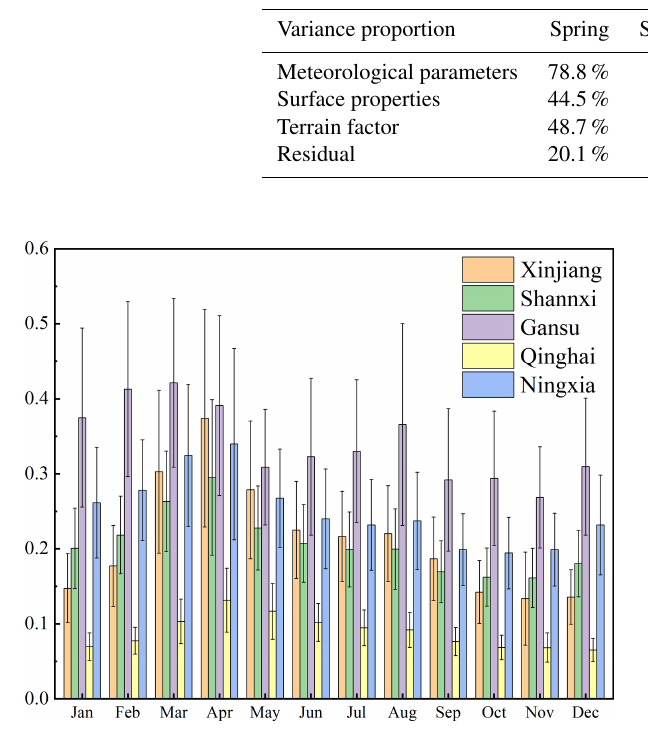
Figure 9. The monthly AOD distribution characteristics in different provinces/autonomous regions. The error bars represent the stan- dard errors.